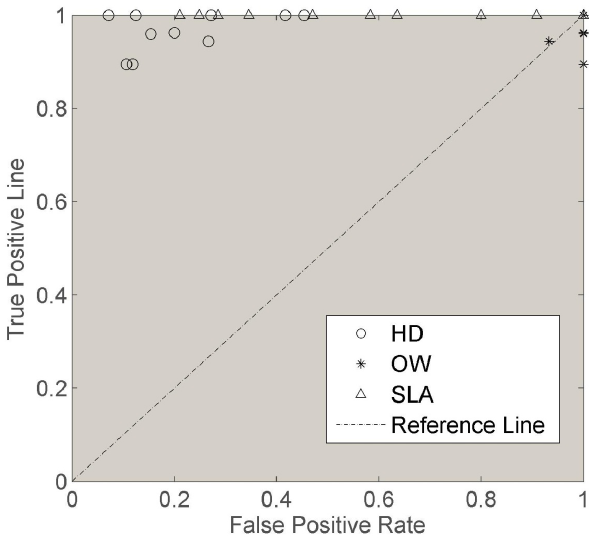
Figure 7. the ROC analysis result of the detection methods in the SCS. 2 Fig. 7. The ROC analysis result of the detection methods in the SCS.